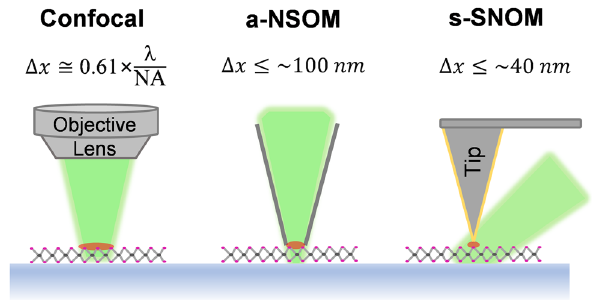
Figure 1: Schematics of confocal, a-NSOM, and s-SNOM microscopes applied to optical investigation of 2D-TMDs. a-NSOM: aperture-type near-field scanning optical microscopy. s-SNOM: scattering-type scanning near-field optical microscopy. Δ x repre- sents typical size of spatial resolution achievable by respective methods. λ : light wavelength; NA: numerical aperture of objective lens. Red spots represent excitation area of 2D-TMDs and green shadow represents laser